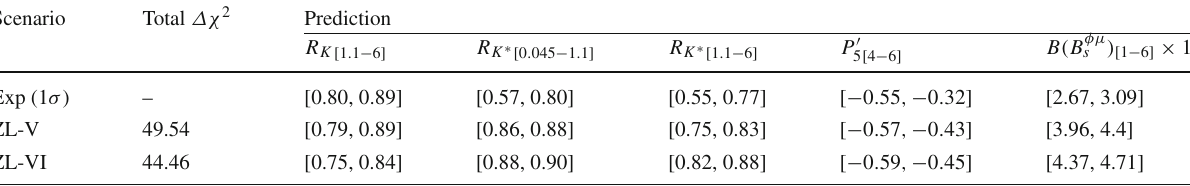
Table 5 Fit results for favoured scenarios in light Z (cid:4) model Scenario